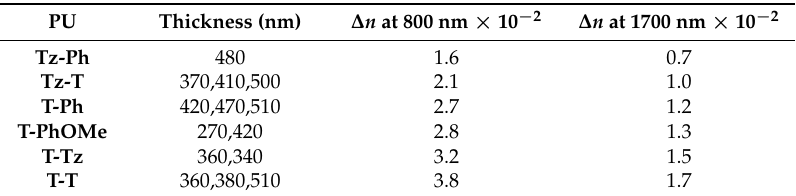
Table 1. Ellipsometric measurements of the film thickness and Δ n values at 800 and 1700 nm for films of photochromic polyurethanes.